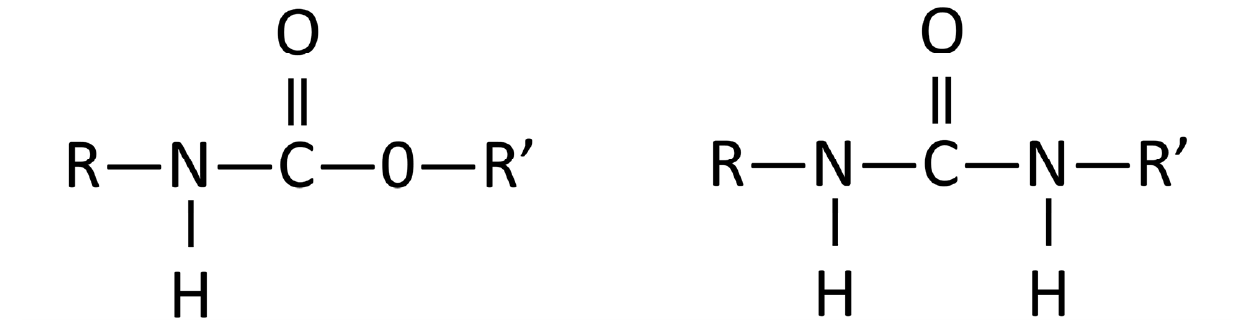
Figure 1. Molecular structure of the urea bond and carbamate. Table 2. Technical properties of